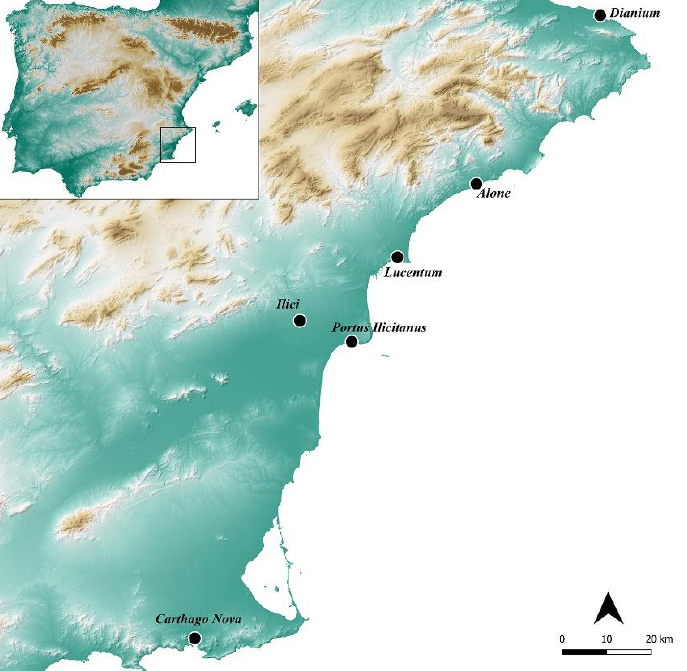
Figure 1. General map showing the location of Portus Ilicitanus in relation to the Roman cities in the surrounding area.